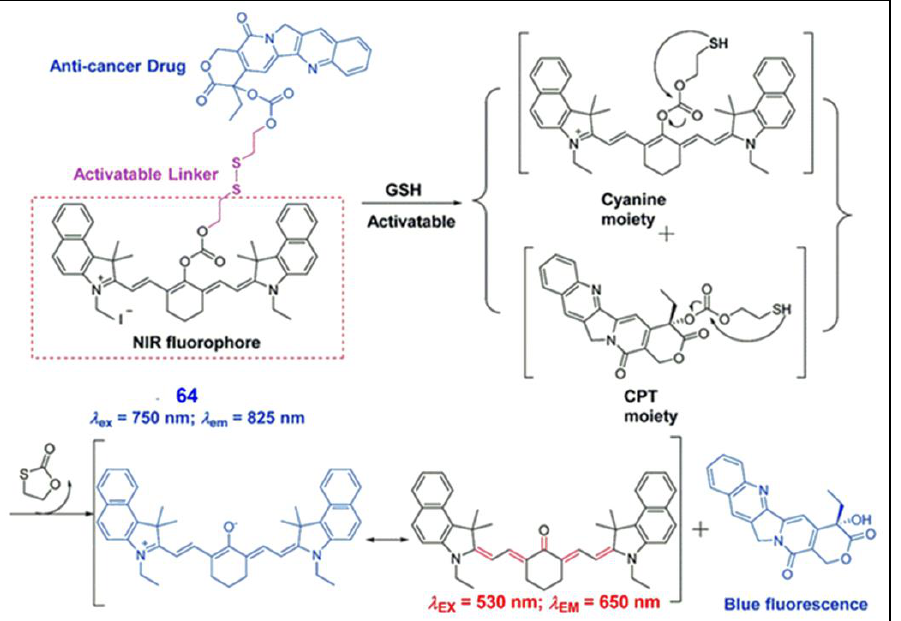
Figure 59. Proposed mechanism in CPT activation and fluorescent variation of the prodrug 64 by the treatment of GSH [168].